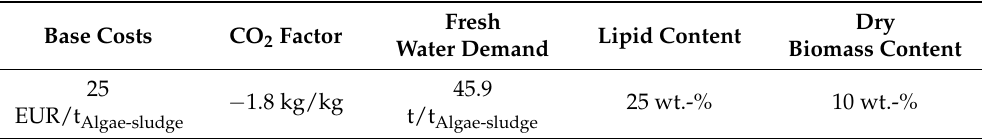
Table 3. Key assumptions of algae biomass raw material (data adapted from